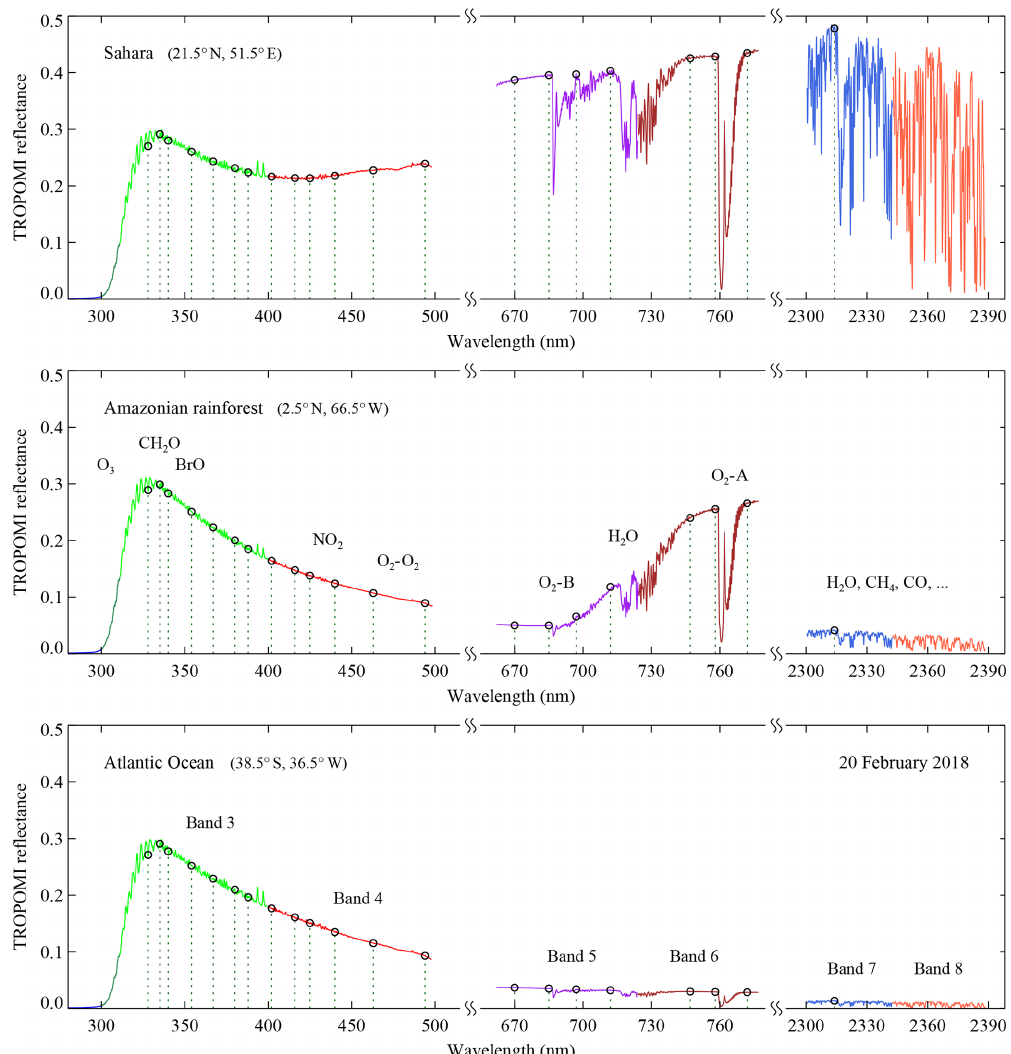
Figure 1. Reflectance spectra measured by TROPOMI on 20 February 2018 while observing the Sahara, the Amazonian rainforest, and the Atlantic Ocean. In all three cases there was almost no cloud presence in the observed scene. Each TROPOMI spectral band was given its own colour. The black dotted lines indicate the position of the 21 wavelength bands that were selected for this study. In the middle panel, absorption bands are indicated by labels of the corresponding trace